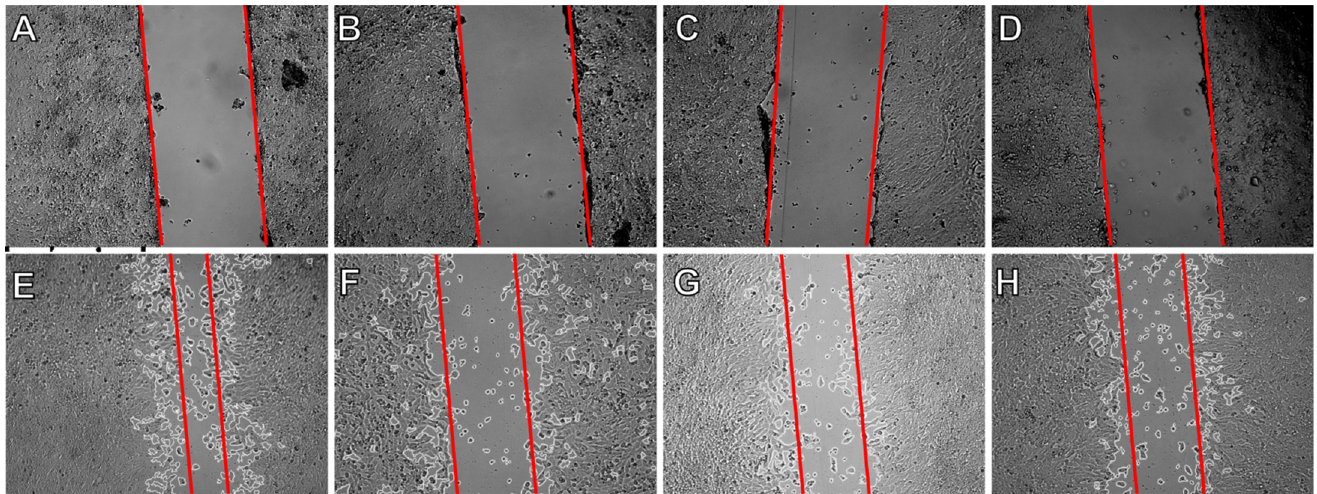
Figure 7. Scratch tests: ( A ) control T 0 ; ( B ) compound 3g T 0 ; ( C ) cisplatin T 0 ; ( D ) 5-FU T 0 ; ( E ) control T 24h ; ( F ) compound 3g T 24h ; ( G ) cisplatin T 24h ; ( H ) 5-FU T 24h . Compound 3g , cisplatin, and 5-FU at concentrations of 100 µM. The red lines indicate the width of the scratch. Microscope magnification was set at 4×.